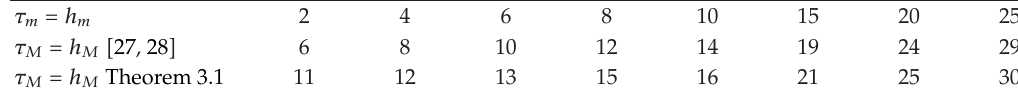
Table 1: Maximum allowable delay bounds for Example